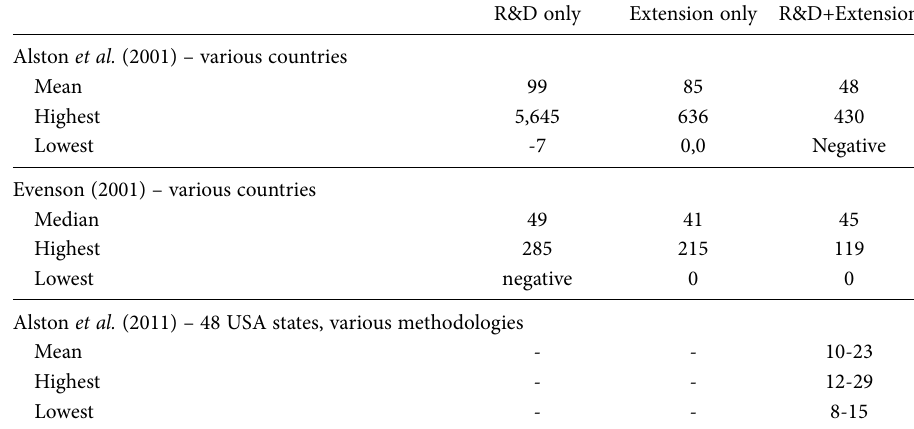
Table 4. Estimated annual marginal internal rates of returns (%) to agricultural R&D and extension R&D only Extension only